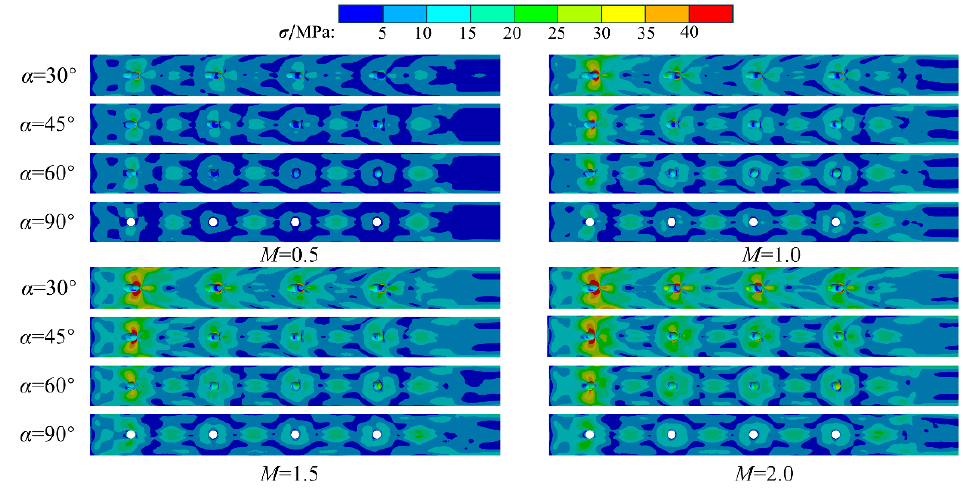
Figure 16. Contours of thermal stress on the internal wall of film plate for all cases.